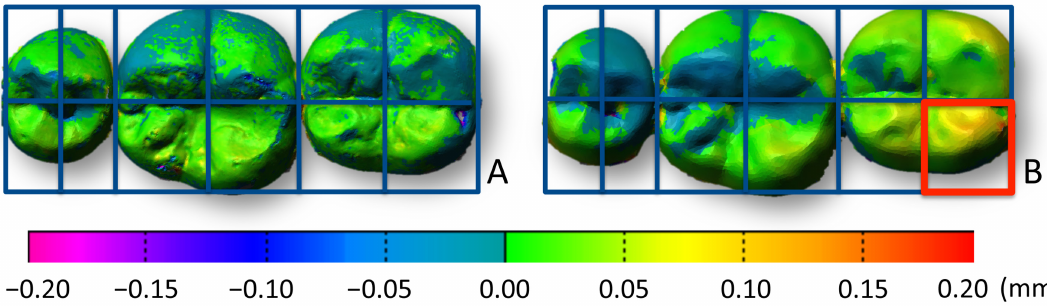
Fig 3. The 3D images were divided into 12 regions and the region with the largest discrepancy was visually identified. A. Digital impressiontechnique. B. Conventional impression technique.The 3D images were dividedinto 12 regions, and the regionwith the largest discrepancy was visuallyidentified(red). The largest discrepancy was frequently found on the lingualsurface of the second molar for the conventional impressiontechnique(8 out of 12 participants), whereasno such trend was found for the digital